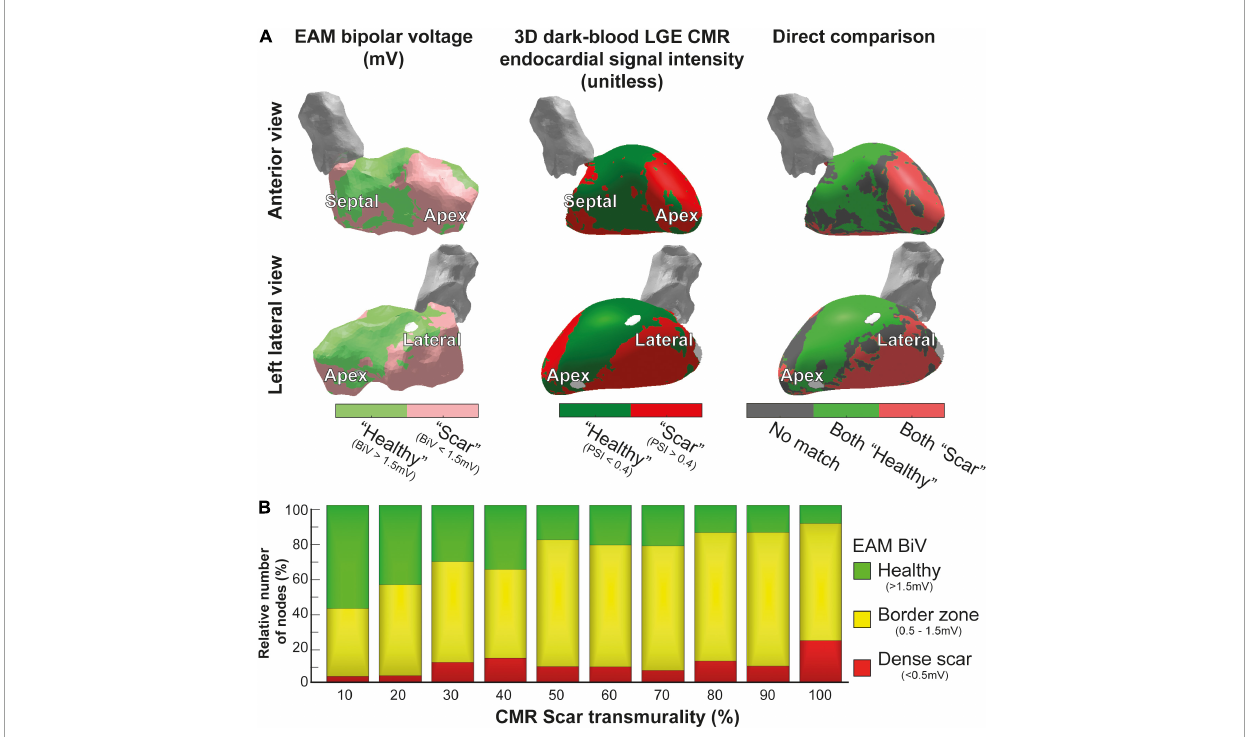
FIGURE3 Comparison of 3D-late gadolinium enhancement cardiac magnetic resonance imaging (LGE CMR) to electroanatomical mapping (EAM). (A) Invasive EAM bipolar voltage map (left) and 3D dark-blood LGE CMR endocardial signal intensity (middle), and the comparison of both (right). Areas of agreement regarding healthy tissue are shown in green, agreement regarding scar tissue are shown in red, and differences between both maps are shown in gray. (B) CMR scar transmurality compared to EAM bipolar voltage. Higher transmurality of scar (detected by 3D-LGE CMR) was associated with lower bipolar voltage in